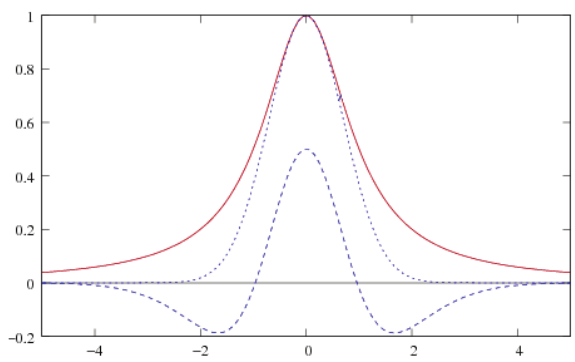
Fig. 3. The cross-section shapes of the Gaussian (exponential   1 2 x e − ) and Hirvonen-like model functions. Gaussian   2 +  1 x is blue, dotted, Hirvonen-like is red, drawn. Here it is assumed that 2 Q x = , i.e., , M I = and 1 a = and 0. b = The third curve is composite exponential 2 2 0.25 ( where and 0.25 c = illustrating our attempt at modelling both uplift and remote-zone